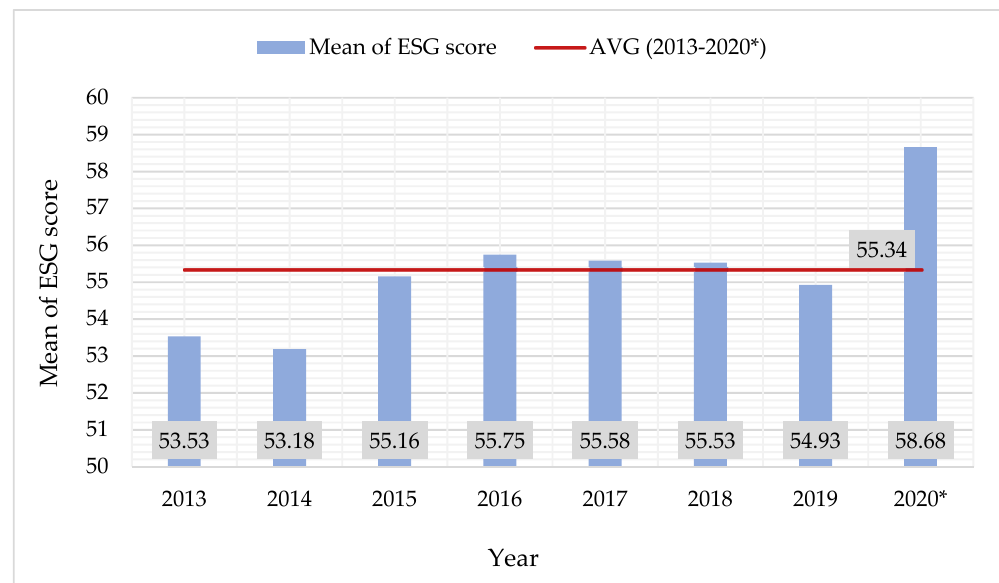
Figure 2. Average values of ESG_SC for sampled companies in the European energy sector. Notes: * data requested as of